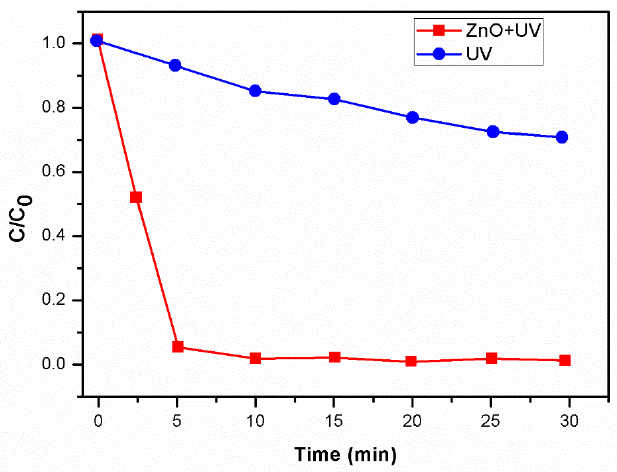
Figure 11. Time-dependent photocatalytic degradation and photolysis of textile Orange 16 reactive dye concentration (C/C 0 ). dye concentration (C/C 0